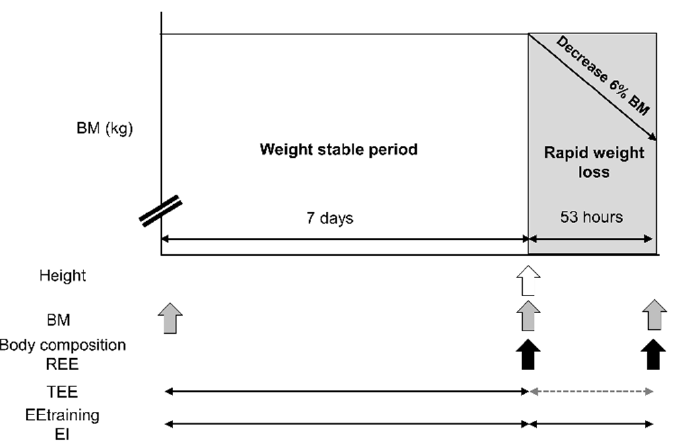
Figure 1. Experimental design. Abbreviations: BM, body mass; REE, resting energy expenditure; TEE, TEE during rapid weight loss indicated by dashed arrow was obtained by conversion of the TEE during the weight stable period into 53 h; EEtraining, energy expenditure during training calculated by rate of the perceived exertion with METs compendium; EI, energy intake.